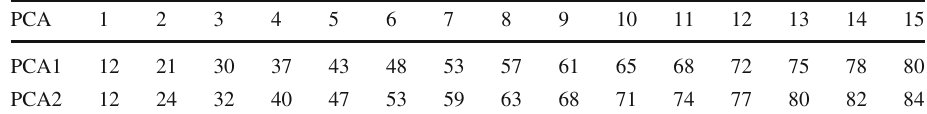
comparisons between groups. PCA1 (see animation here) is shown on thetoprow,PCA2(seeanimationhere)onthebottomrow,theleftviews show a separation between DIS and jets clusters, the right views show the multidimensionality in the DIS